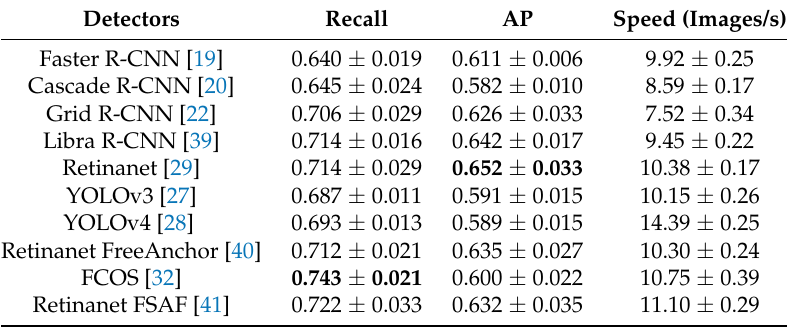
Table 9. Results on the EPD-C subset. Train resolution, 1 m/pixel; test resolution, 2 m/pixel. AP refers to average precision. Recall, AP, and speed are expressed in the format of mean ± standard deviation on the basis of 10 rounds of test results.